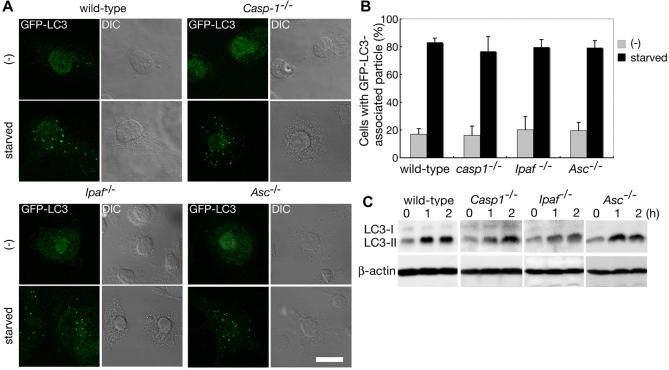
Autophagy Induced by Amino Acid Starvation or Rapamycin Treatment Is Independent of Caspase-1, Ipaf, and ASC(A) GFP-LC3-expressing wild-type BMMs and caspase-1-deficient, Ipaf-deficient, or ASC-deficient BMMs were incubated in amino acid–starved conditions for 2 h. GFP fluorescence and differential interference contrast (DIC) were shown separately. Scale bar = 10 μm.(B) BMMs with GFP-LC3-associated autophagosomal particles were quantified. Error bars represent mean ± SD.(C) Endogenous LC3-I to LC3-II conversion upon rapamycin treatment was analyzed by western blotting using anti-LC3 antibody. The immunoblot for β-actin was indicated as an internal control.